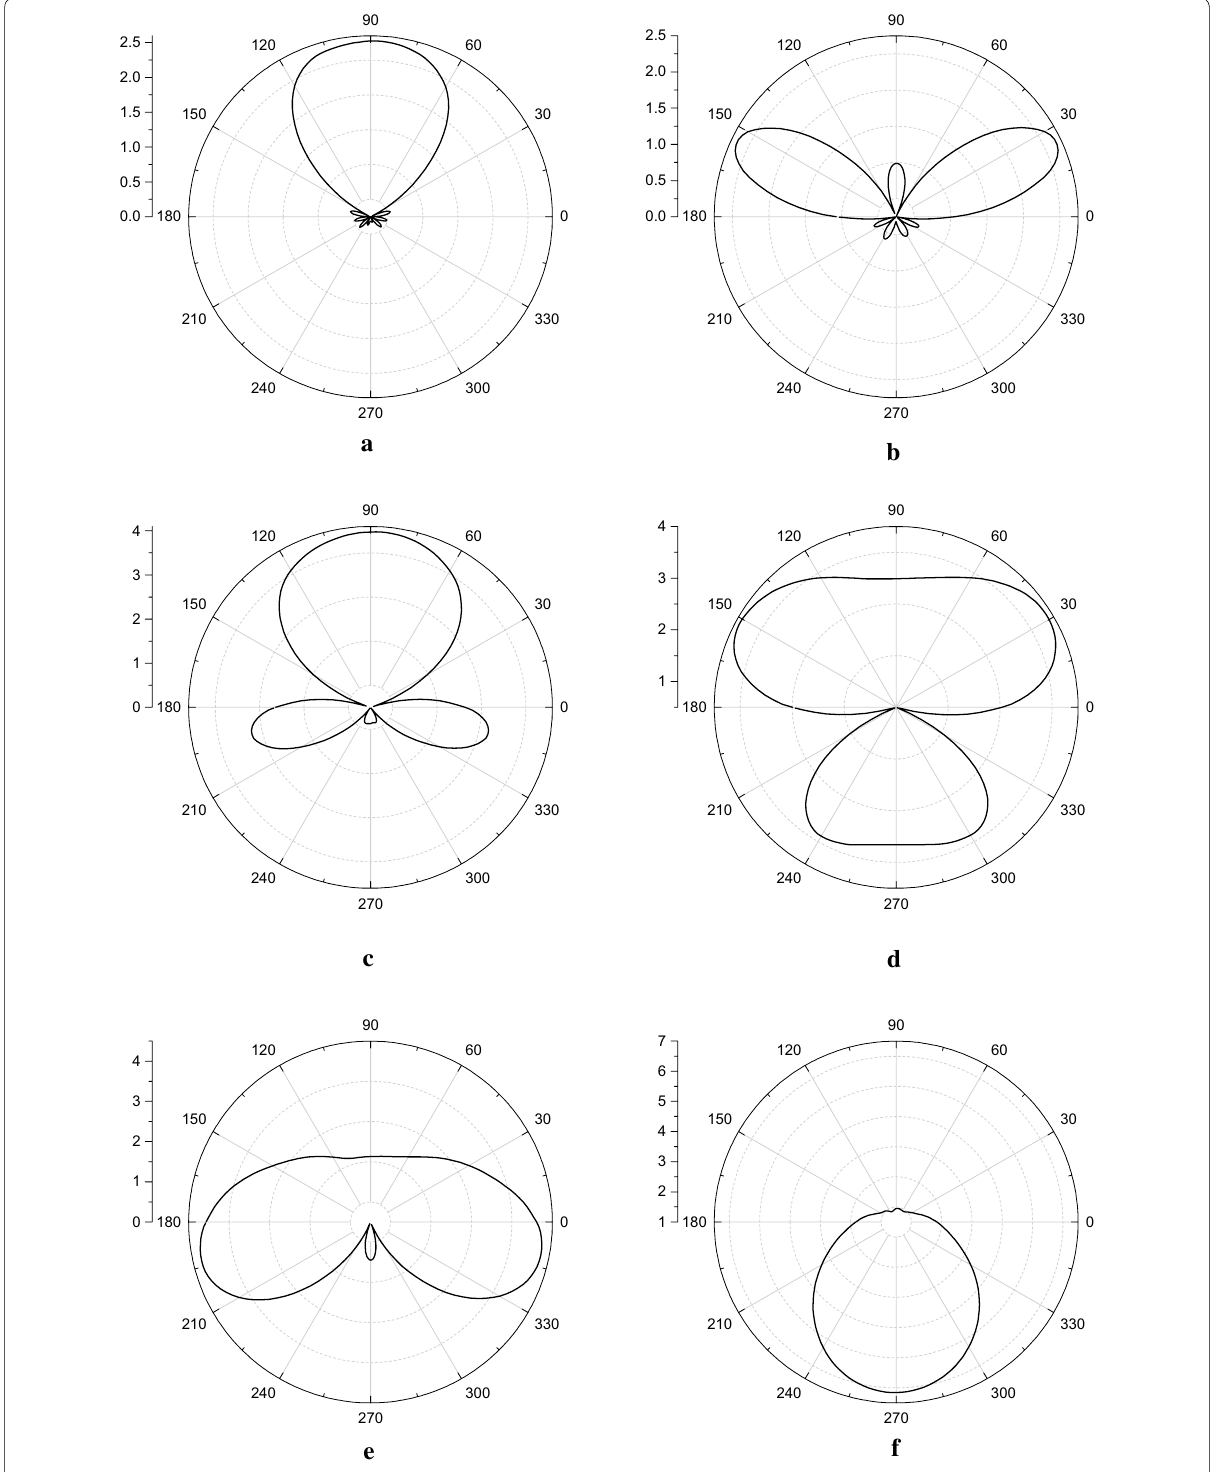
Figure 5 Pressure distribution of the ultrasonic field for a single cylinder at various instants (impulse signal amplitude is 20, f = 850 kHz ): a t = 4.2 µ s, b t = 4.2 µ s, c t = 4.6 µ s, d t = 4.8 µ s, e t = 5.0 µ s, and f t = 5.2 µ